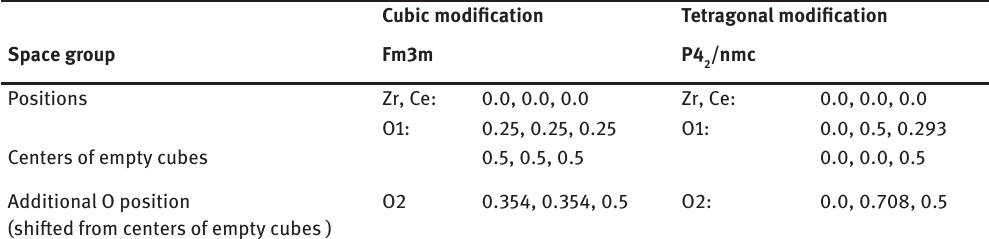
Table 3: Transformation of atomic positions from cubic to tetragonal system.